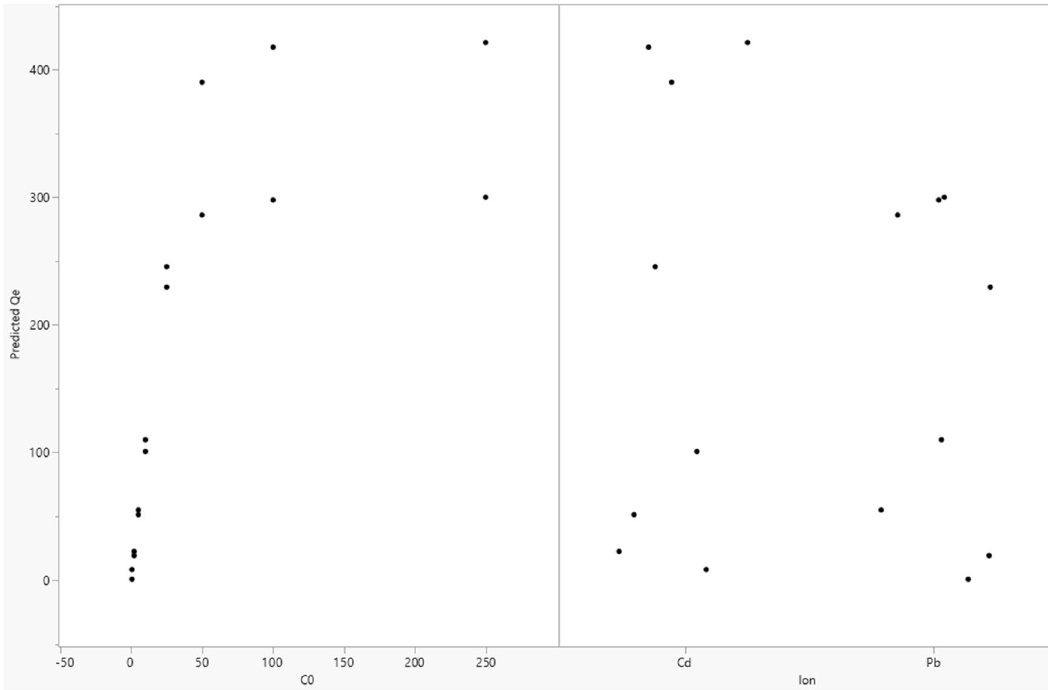
Figure 6. Scatterplot matrix of predicted Qe.